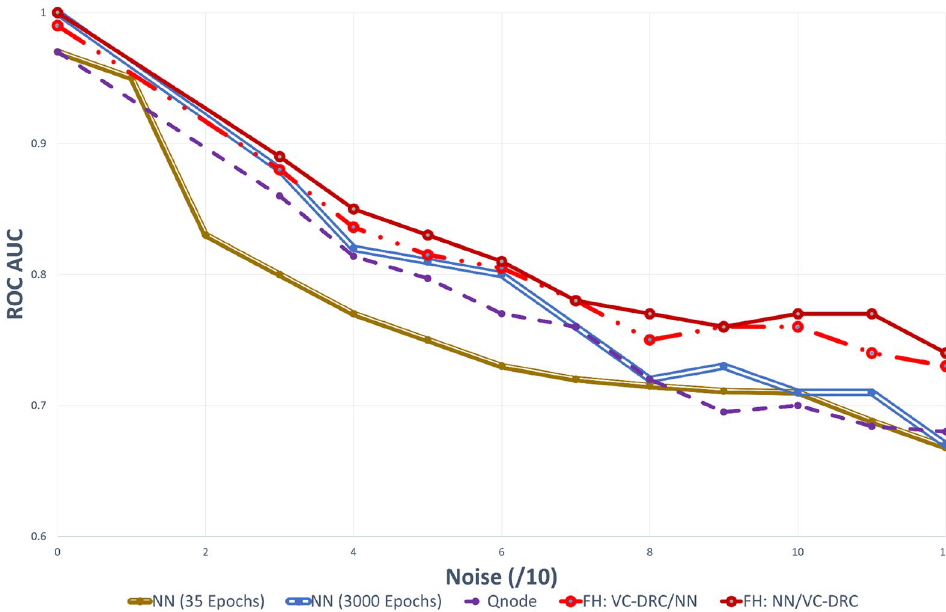
Figure 4. AUC–ROC curve for increasing level of noise for the classification of 2d dataset. Here we benchmark FH versus just the classical part (NN) and versus just the quantum part (Qnode).